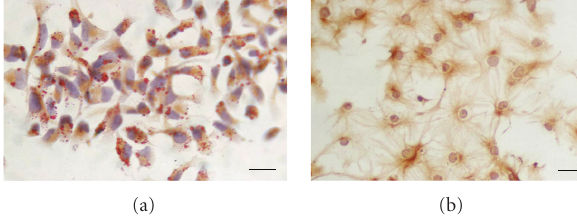
Figure 9: Double oil red/nestin in S0 neurospheres (a) and oil red/GFAP in S10 (b) neurospheres. Bar = 20 μ